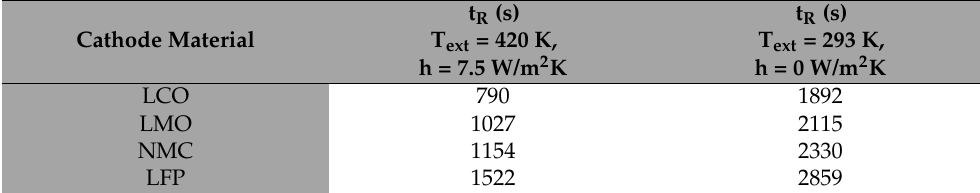
Table 8. Thermal runaway ignition times for different cell materials and conditions. Cathode